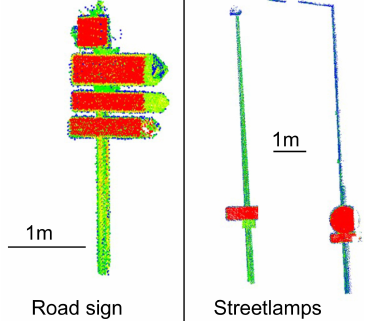
Figure 3. Example of the point clouds